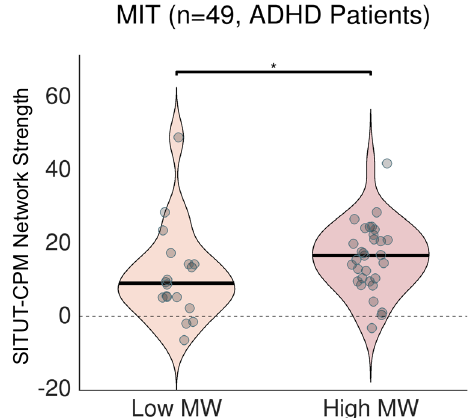
Fig. 6 SITUT-CPM network strength during rs-fMRI is greater in adults with ADHD with high compared to low Mind Wandering Questionnaire scores. Individuals were classi fi ed as people showing high levels of mind wandering and people showing low levels of mind wandering based on the Mind Wandering Questionnaire. SITUT-CPM network strength was computed based on the dot product of SITUT-CPM suprathreshold edges (see “ Methods ” and Fig. 1) and connectivity values in a given resting-state scan ( P = 0.043, two-sided, Wilcoxon rank-sum test). Solid black horizontal line indicates median. SITUT stimulus-independent, task- unrelated thought, CPM connectome-based predictive model, MW mind wandering. * P < 0.05. Source data are provided as a Source data fi